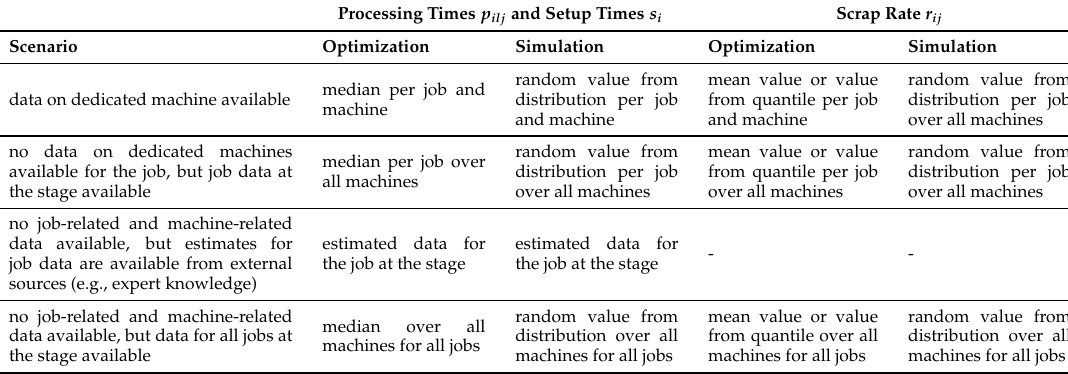
Figure 3. Boxplot for processing times for one exemplar of similar jobs j on different machines at stage 1 of the same machine type. Table 1. Data concept for scheduling parameters in optimization and